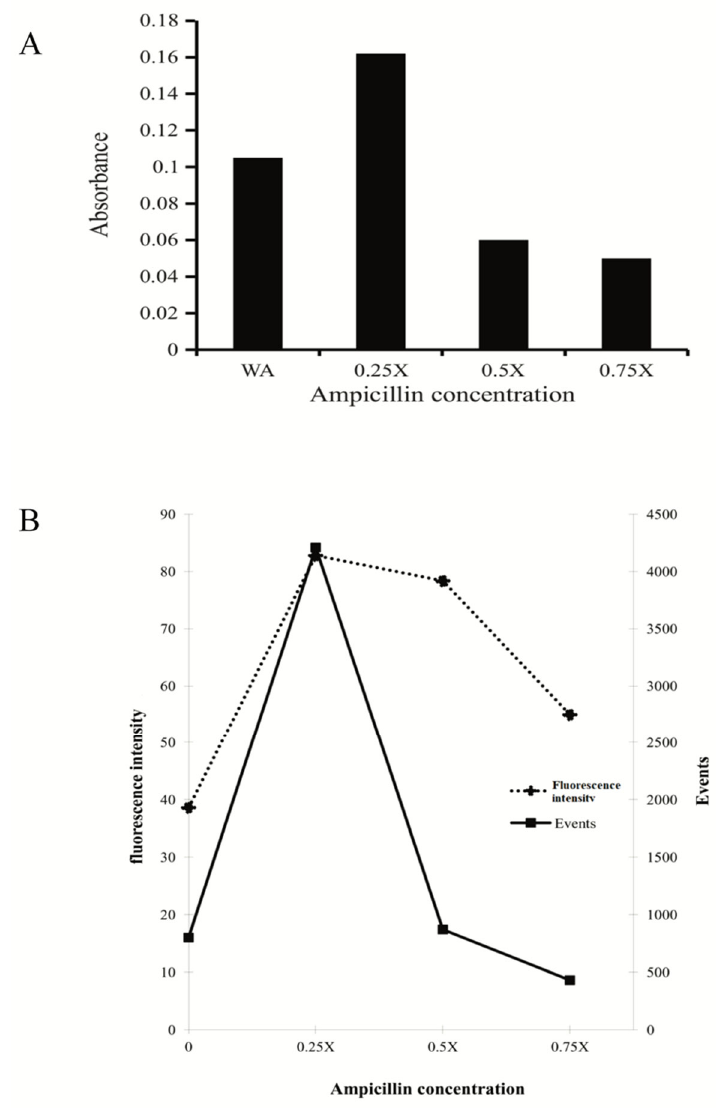
Figure 5. Expression of aggregated substance by the 1390R strain upon exposure to different stimuli. ( A ) ELISA for the detection of AS in the presence of different concentrations of antibiotic (comparative analysis between groups: WA vs. 0.25×: p < 0.0022 **, WA vs. 0.75: p < 0.0165 *, 0.25× vs. 0.5×: p < 0.0002 ***, 0.25× vs. 0.75 p < 0.0001) (comparative analysis of the experimental groups vs the control: WA vs. 0.25× P= 0.0013 **, WA vs. 0.75×” p = 0.0099 **). ( B ) Analysis of AS expression on the cell surface by flow cytometry. The mean fluorescence intensity represents the total detected fluorescence, whereas events represent the count of fluorescent cells (one way ANOVA p < 0.0001. Tukey’s multiple comparison test: 0 vs. 0.25× p <0.0001 ****, 0 vs. 0.50× p < 0.0001 ****, 0 vs. 0.75× p < 0.0028 **, 0.25 × vs. 0.50 × p = 0.4825, nonsignificant, 0.25× vs. 0.75× p < 0.0016 **, and 0.50 × vs. 0.75 × p < 0.0099, Dunnett’s multiple comparisons test 0 vs. 0.25× p < 0.0001 ****, 0 vs. 0.50× p < 0.0001 ****, 0 vs. 0.75× p < 0.0016 **). Statistical significance is indicated by a single asterisk (*) for p = < 0.05, double asterisk (**) for p = < 0.01, triple asterisk (***) for p = < 0.001, and four asterisks (****) for p = < 0.0001.